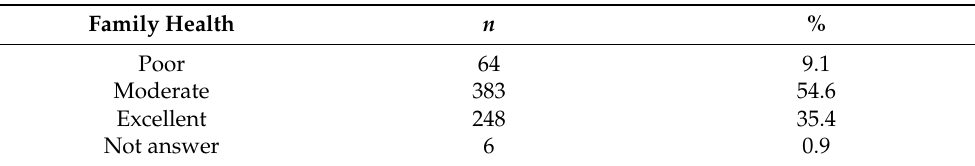
Table 2. Parent-reported family health among Thai families with primary school children during the COVID pandemic in